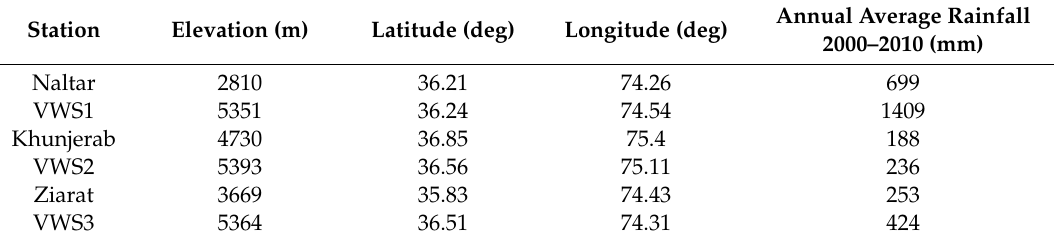
Table 3. Climate / meteorological stations in the Hunza